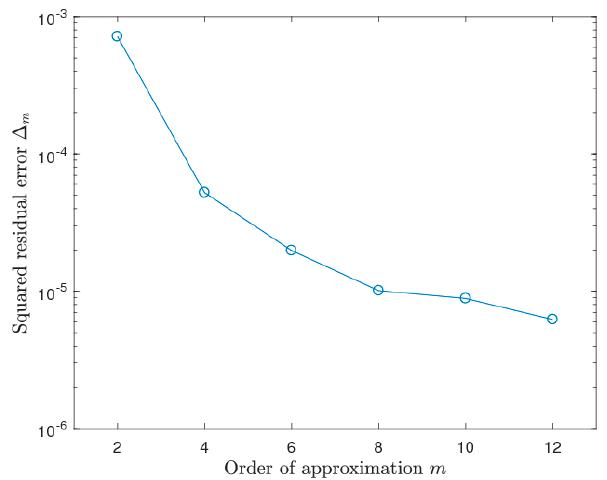
Figure 5. Squared residual error ( ∆ m ) versus different orders of approximations ( m ) of the HAM- based solution for the selected case. Table 1. Squared residual error ( ∆ (cid:3040) ) and computational time versus di ff erent orders of approxima- tion ( m ) for the selected case.